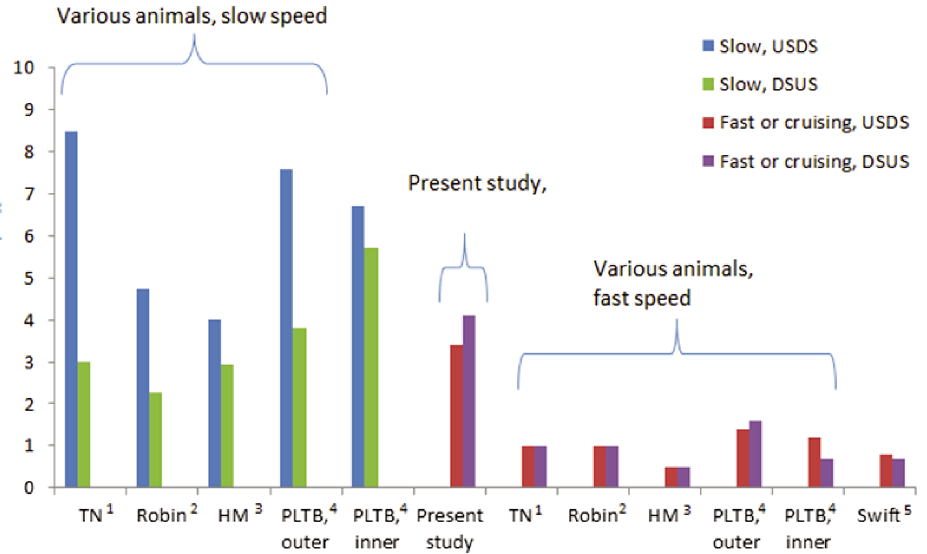
Figure 6. A comparison of the peak normalized spanwise vorticity, v c / U ‘ , measured in the wake of flapping animals from several studies. Superscripts refer to the work of: 1 [20], 2 [22], 3 [45], 4 [4] and 5 [9]. Abbreviations used in the figure represent the Downstroke to upstroke transition (DSUS), upstroke to downstroke transition (USDS), the thrush nightingale (TN), house-martin (HM), and Pallas’ long-tongued bat (PLTB). Measurements from the Pallas’ long-tongued bat have been taken from the inner wing ( z / b semi , 0.4) and outer wing ( z / b semi .